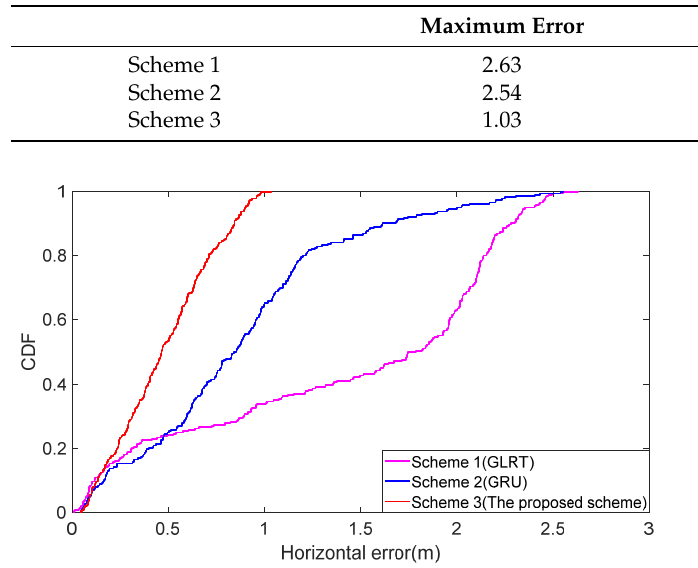
Figure 9. Cumulative distribution function by different methods.